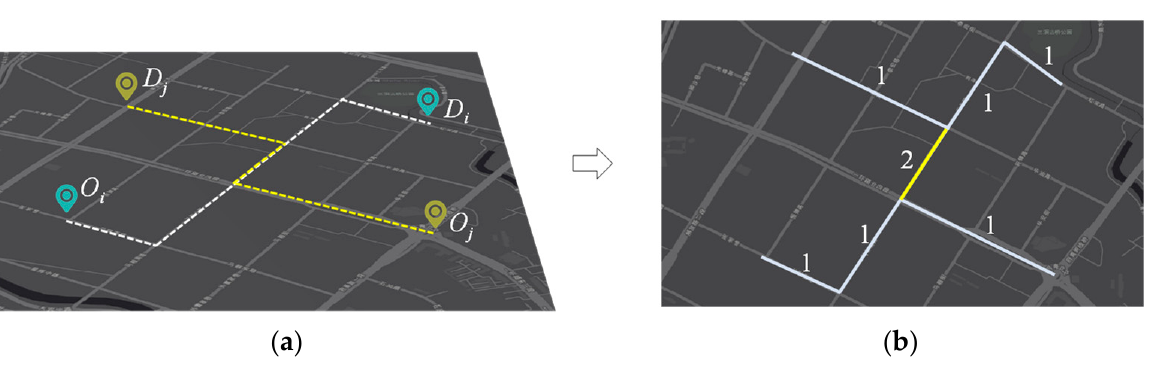
Figure 4. Estimation of traffic distribution on the road network. ( a ) Restore the trip path by the shortest path; ( b ) calculate traffic volume distribution, where the numbers indicate traffic volumes.